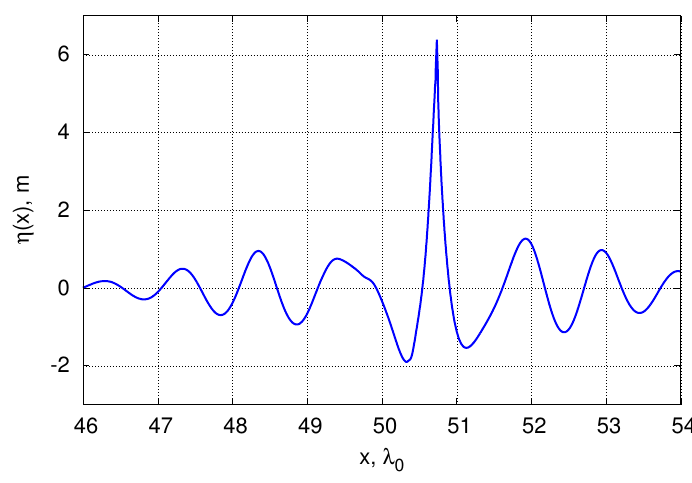
Figure 8. Surface elevation function η ( x ) at the moment of breather collisions right before wave breaking. Parameters of the breathers correspond to experiment 4 with ∆ φ ≈